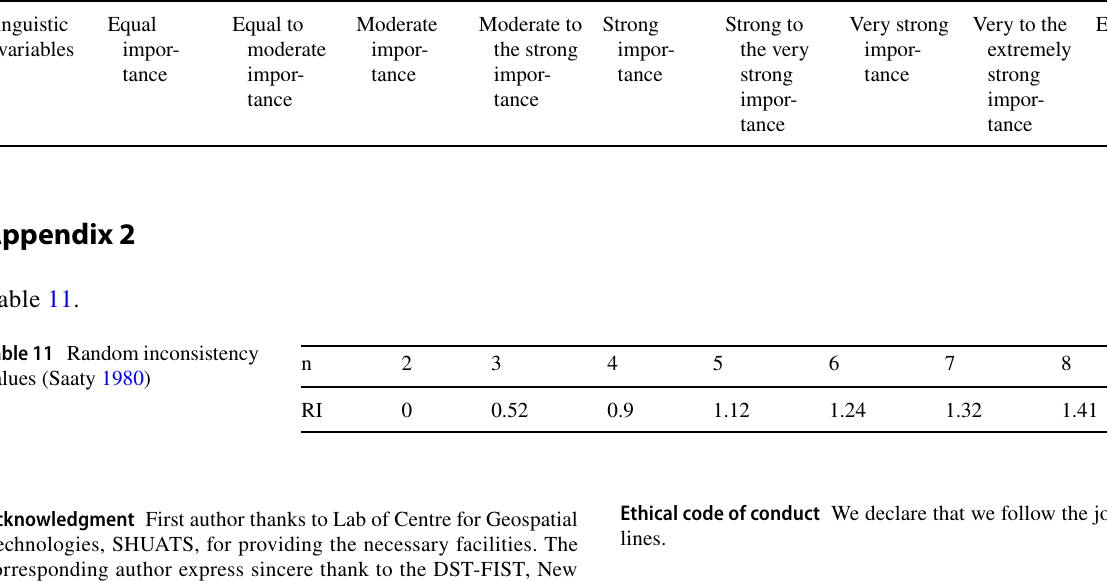
Table 10 Scale for pair-wise comparison matrix Intensity importance